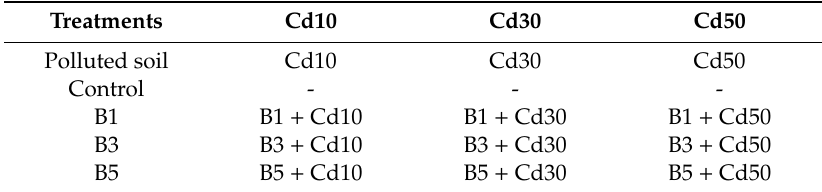
Table 1. Experimental design for